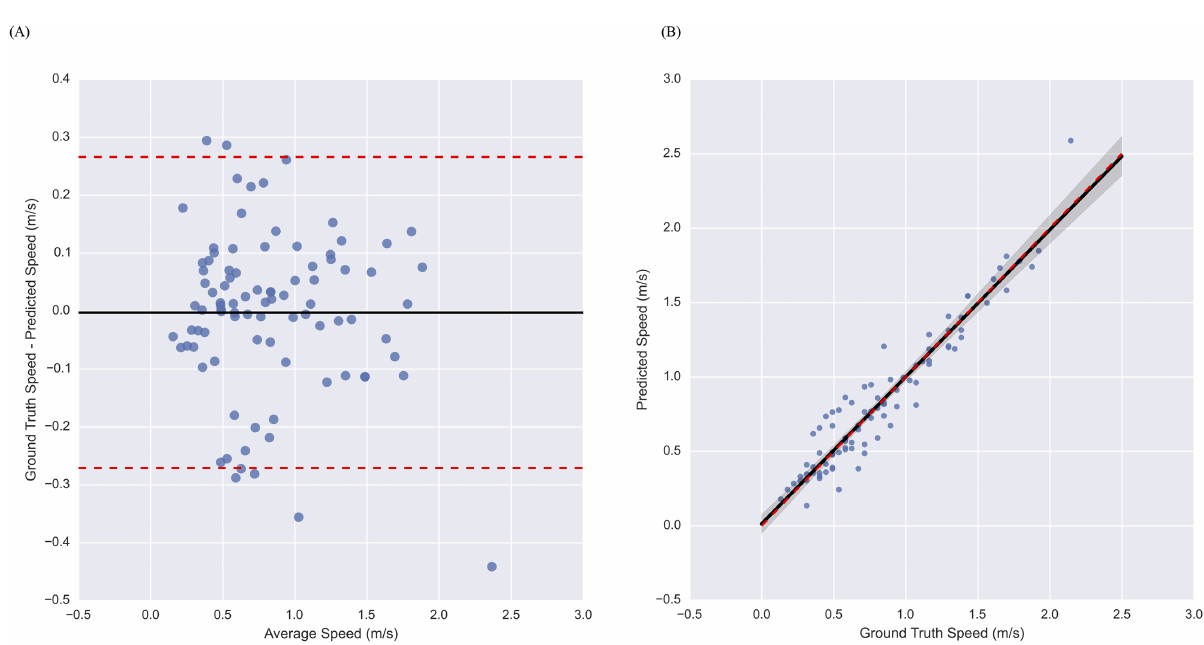
Fig 3. Performanceof model using sacrum, thigh, and shank device locations on treadmill data from MS patients. Bland-Altman (A) and regression(B) plots illustrating the performance of the accelerometer-based model for estimatingwalkingspeedin MS patients. As illustratedin the plots, the model produces unbiased estimates of speed with slightly highervariance at slower speeds, despitebeing trained on data from subjects with normal